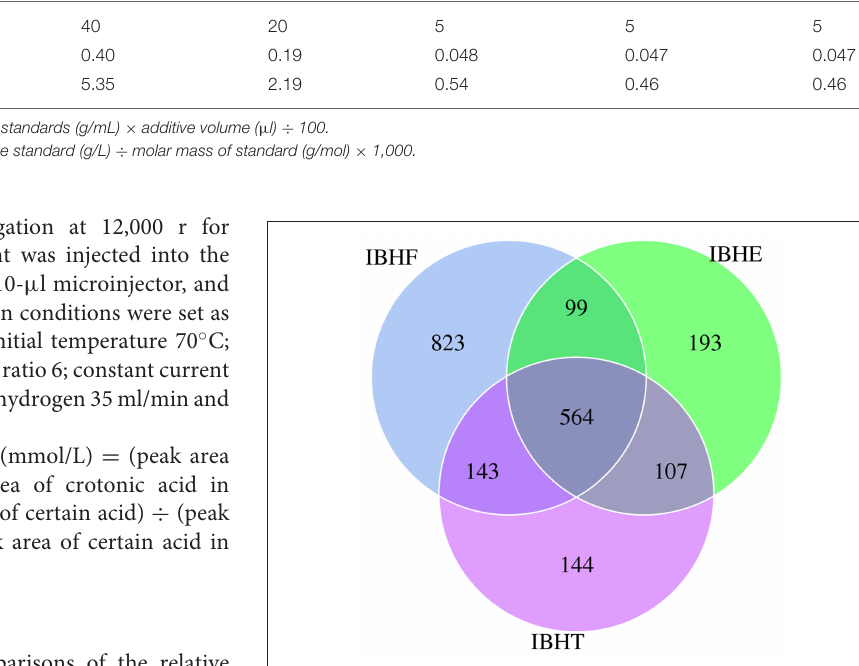
TABLE 2 | The additive volume and concentrations of volatile fatty acid standards added to the standard stored solution. Acetate